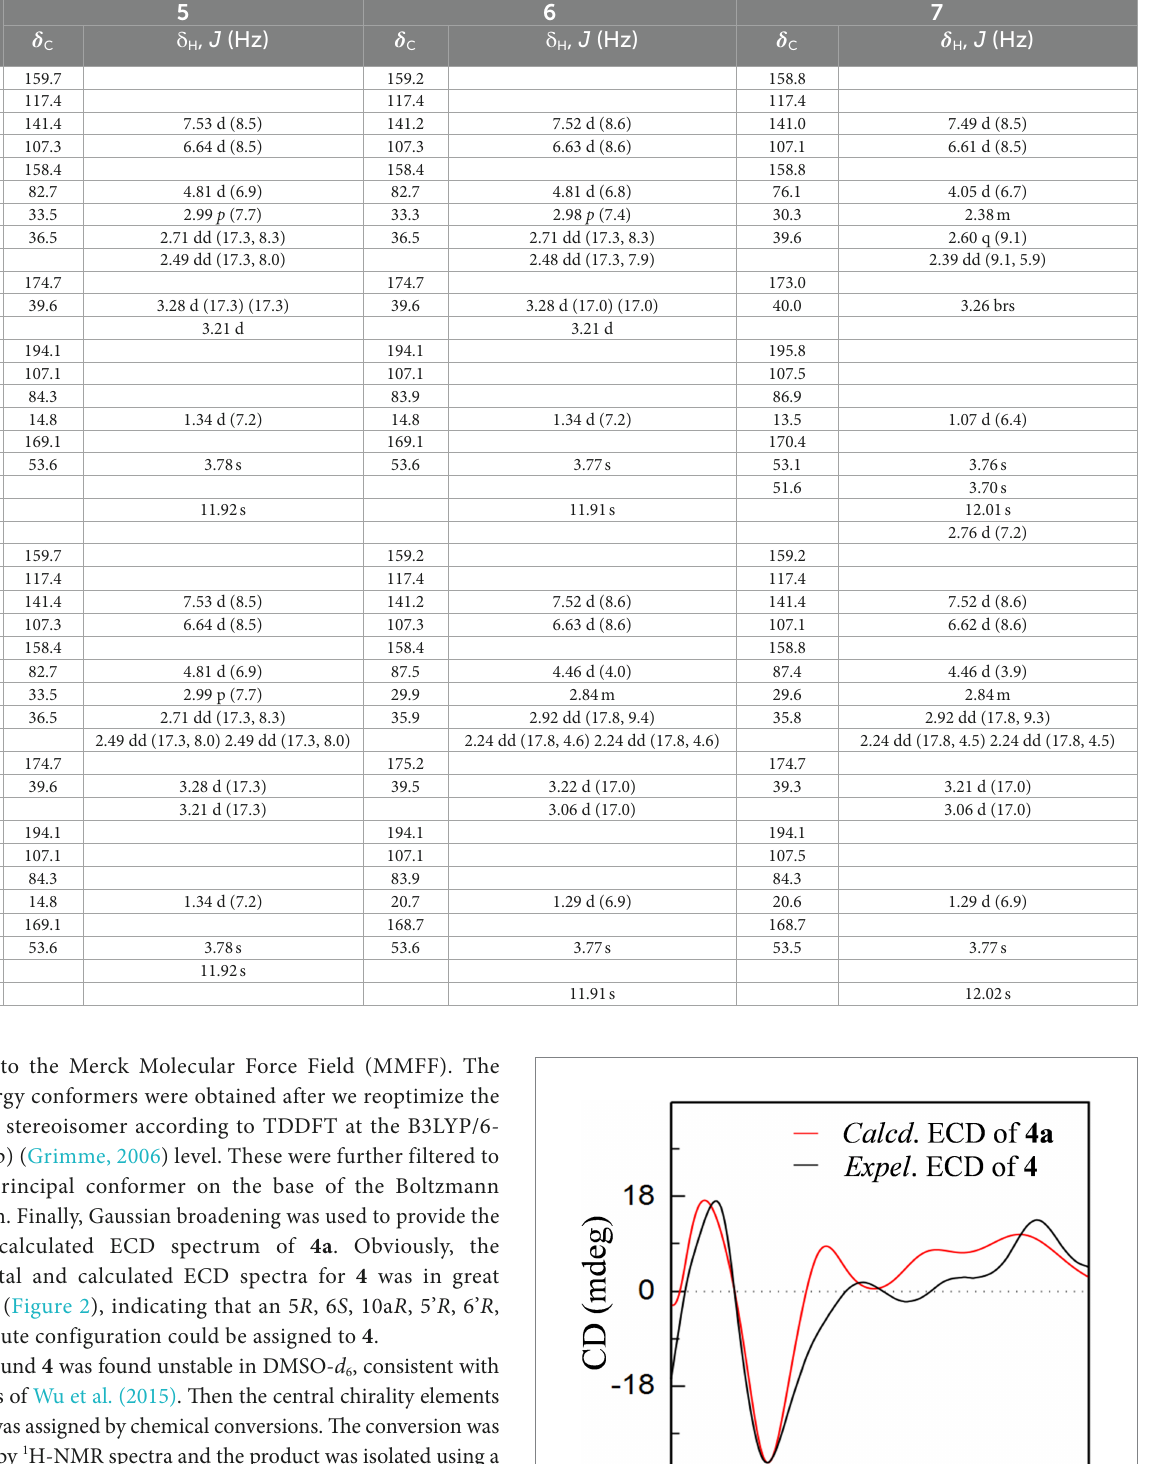
TABLE 2 1 H and 13 C NMR spectroscopic data for 5–7 (CDCl 3 , TMS, δ ppm). No.